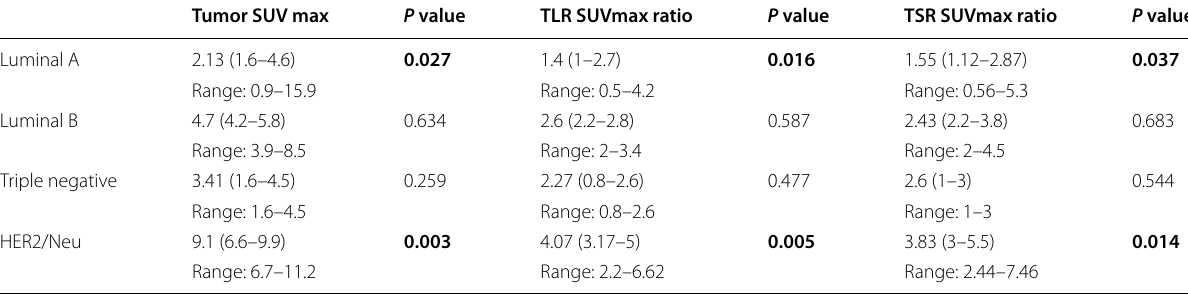
Bold means that the p value < 0.05 and there is a significant relation